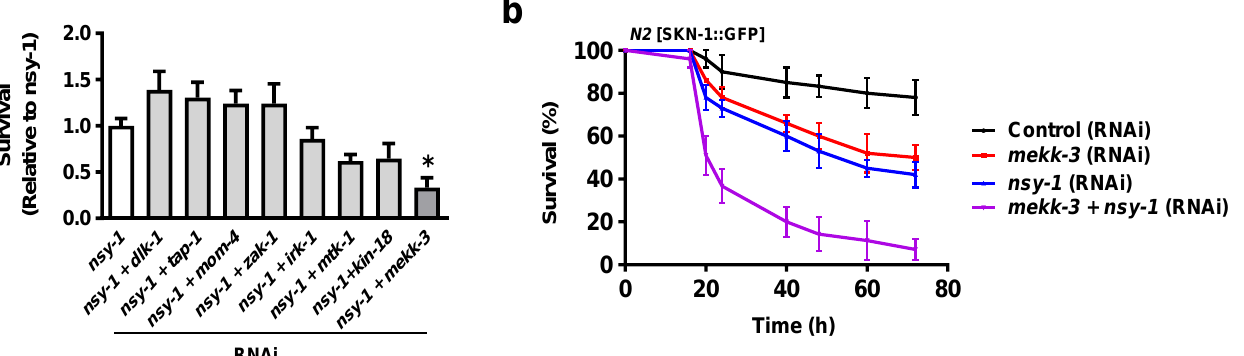
Figure 1. Genetic screening of a novel MAPKKK in SKN-1 transgenic C. elegans . ( a ) RNAi screening was performed in SKN-1 transgenic worms to identify MAPKKKs involved in the resistance to oxidative stress. Worms were fed with bacteria for each RNAi treatment 24 h before exposure to oxidative stress. Oxidative stress resistance assays were performed 16 h after RNAi, and the survival rate was calculated ( n = 3). Data are shown as the mean ± SEM. * p < 0.05. All p values were calculated by ANOVA followed by Dunnett’s multiple comparison tests. ( b ) Oxidative stress resistance assay was performed on SKN-1 transgenic worms fed RNAi bacteria against mekk-3 , nsy-1 , or both mekk-3 and nsy-1 under treatment with 20 mM t-BOOH. Survival rate was calculated at the indicated time points (h). This representative experiment involved 30 worms in each group. Data are shown as the mean ±